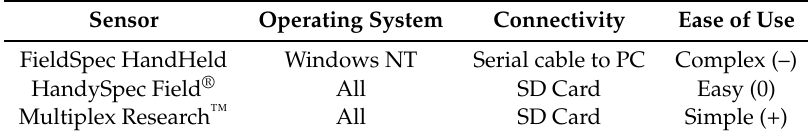
Table 2. Ease of use of the three used sensors and their handling capabilities.